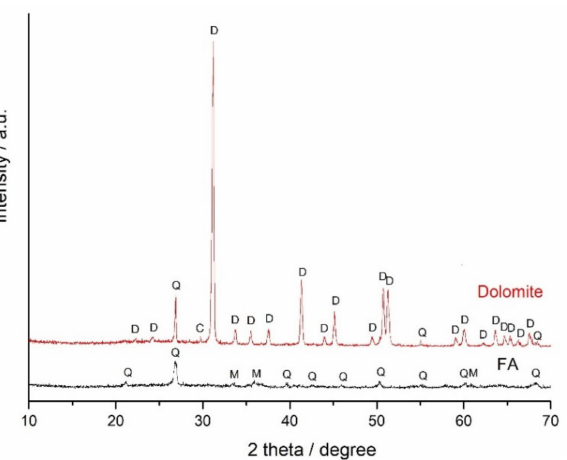
Figure 1. The XRD patterns of the FA and natural dolomite. Phases marked are D—dolomite (ICDD